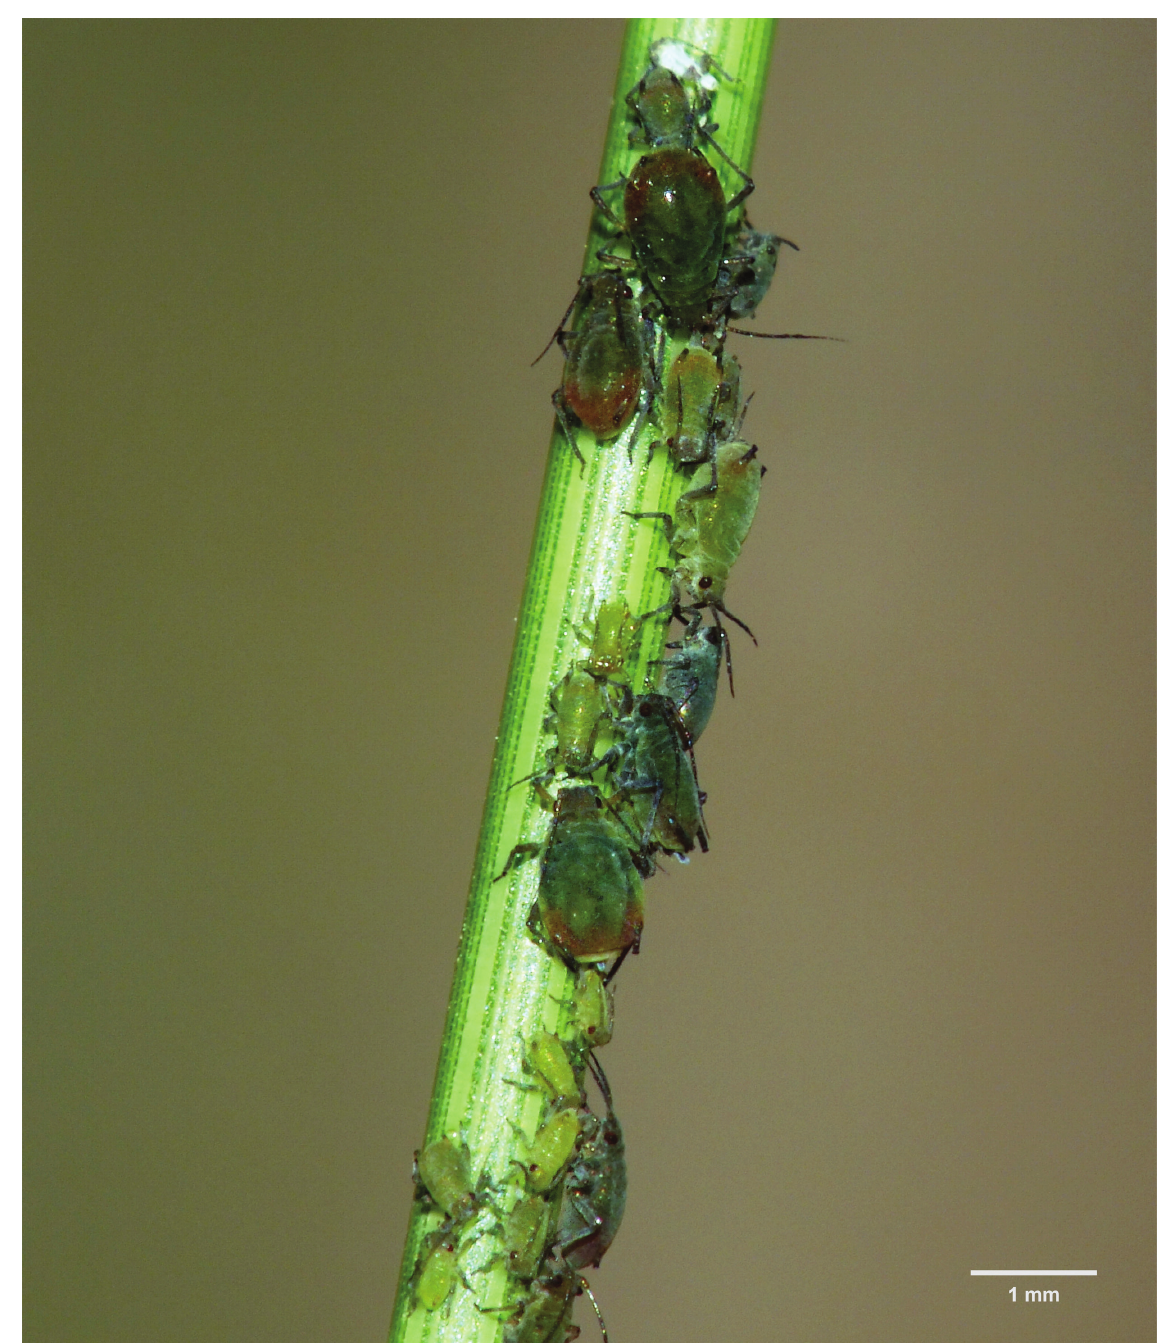
Fig. 25. Rhopalosiphum padi (linnaeus, 1758), apt. and juv. on Poa